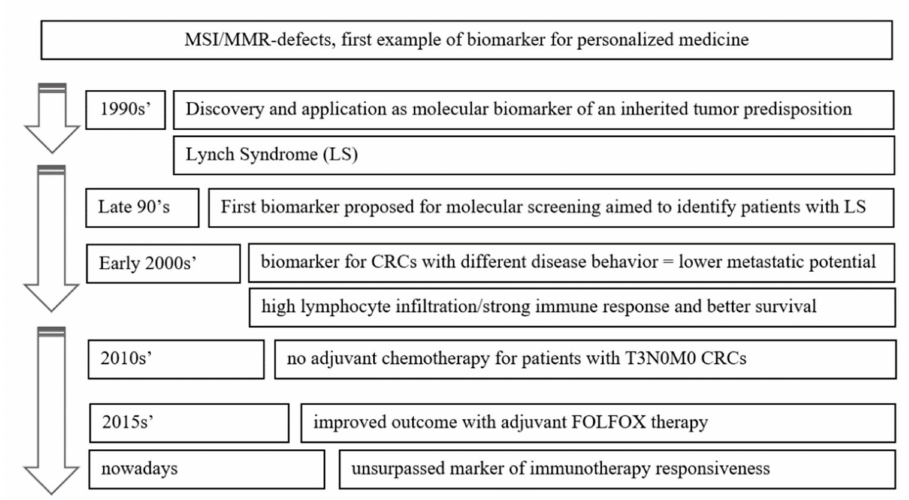
Figure 1. MMR story: lessons from a long-lasting biomarker. Timeline of its gradual achievement of wider clinical